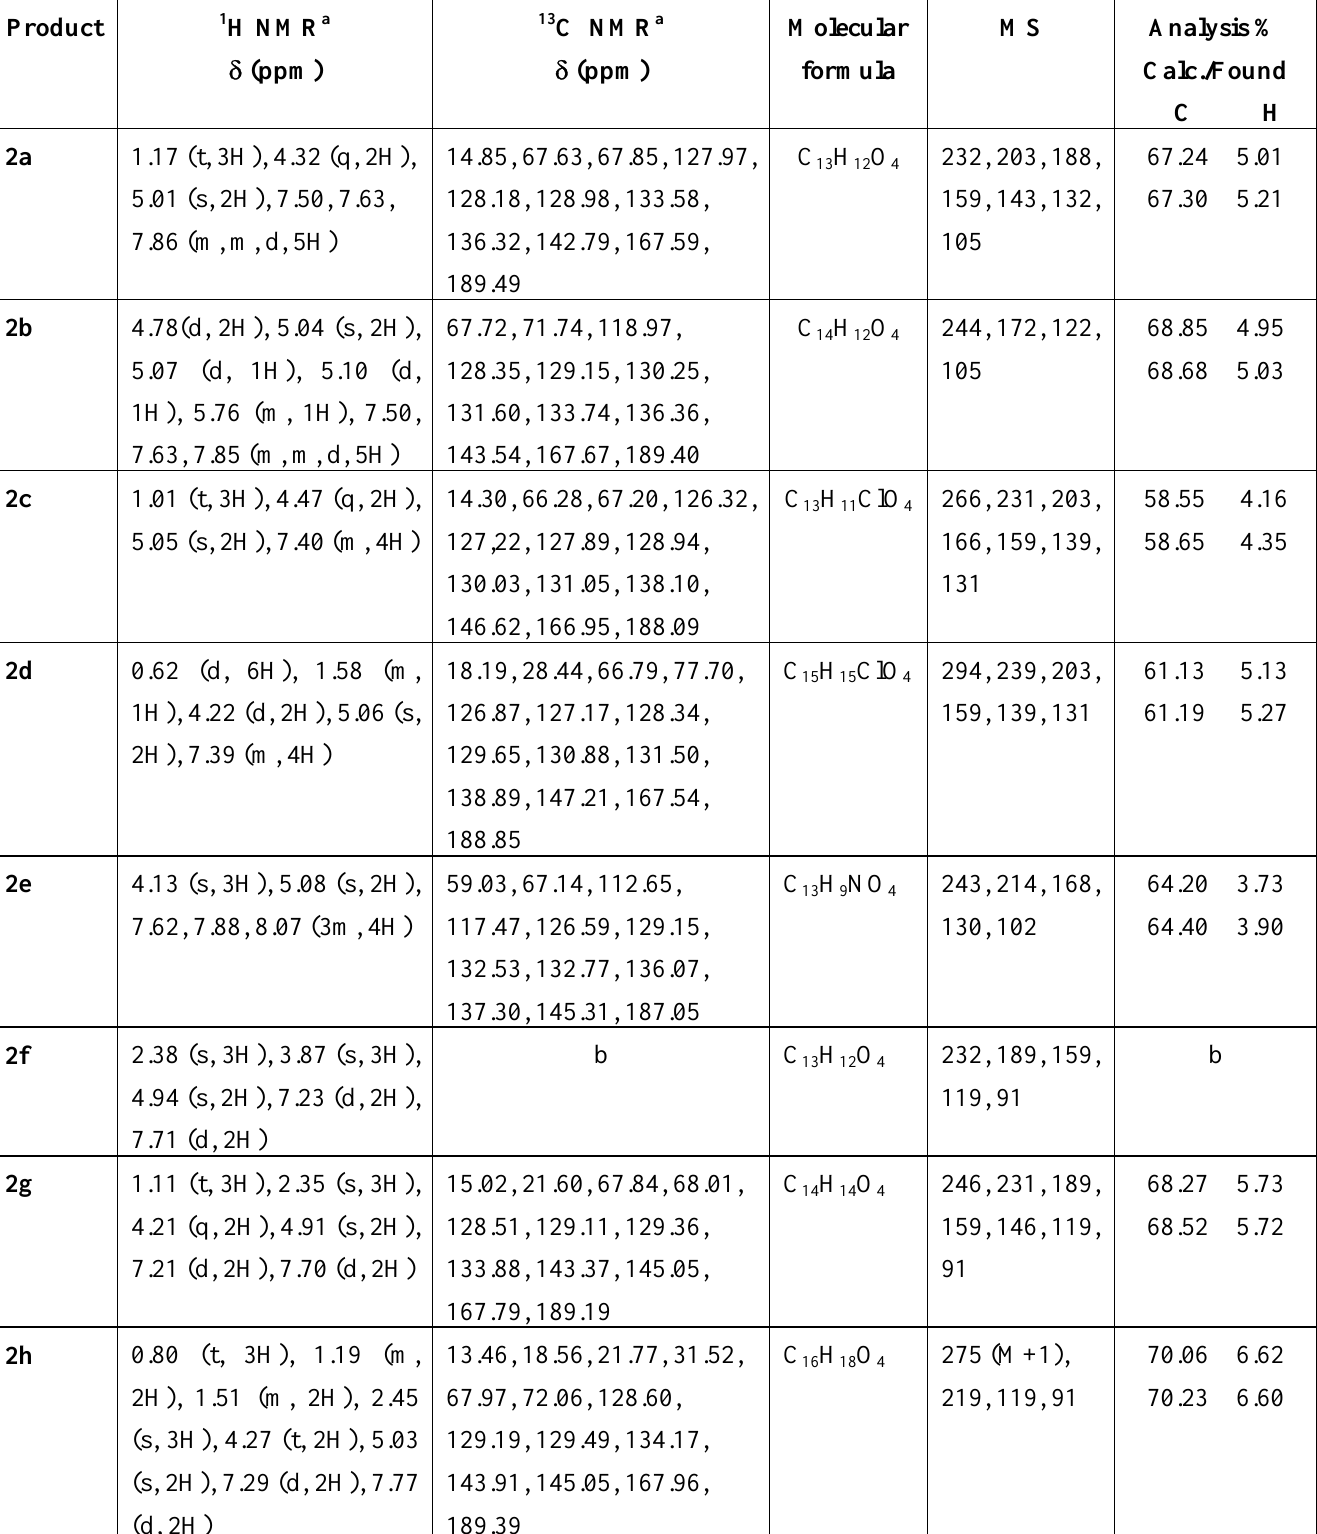
Table 2: 1 H- , 13 C-NMR, MS and analytical data of 2a-q and